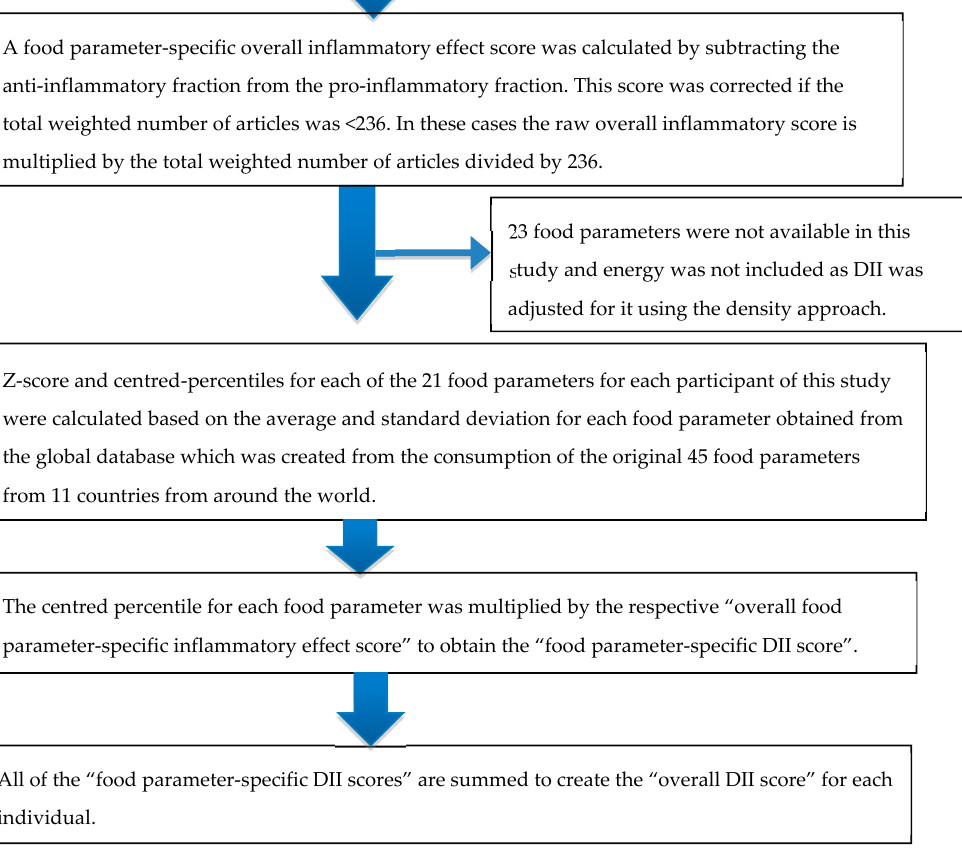
Figure 1. Sequence of steps in creating the energy-adjusted- DII (dietary inflammatory index) in middle-aged black South African